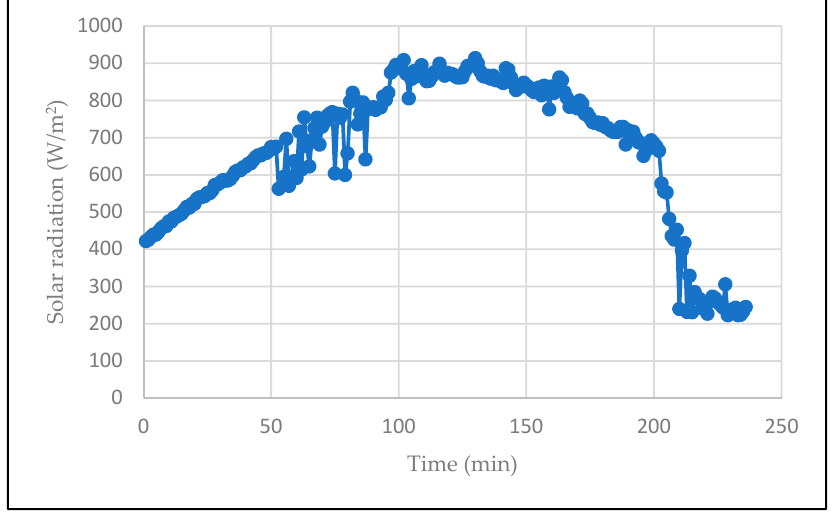
Figure 10. Reading of solar irradiance throughout a day (6 November 2019) during experiment.